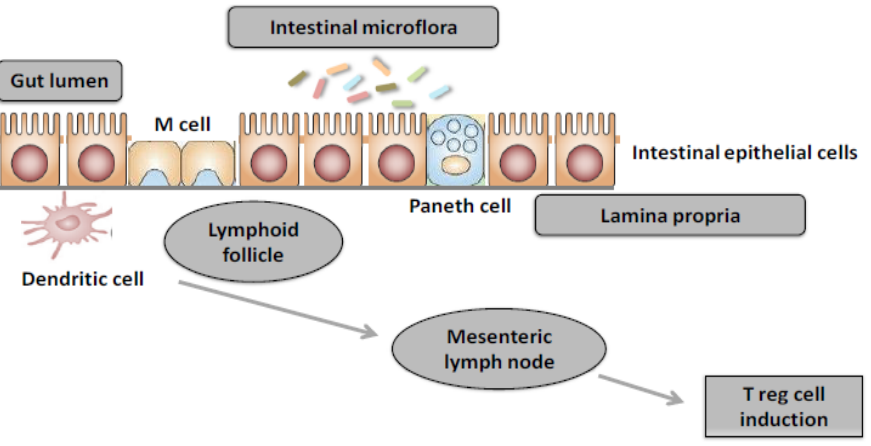
Figure 1. Intestinal microflora drives oral tolerance development. Under homeostatic condition, antigens from selected components of intestinal microflora are acquired in the lamina propria and presented in the mesenteric lymphonodes by CD 103 + dendritic cells. Through mechanisms mainly involving transforming growth factor (TGF) β and retinoic acid, dendritic cells induce the production of gut homing Treg cells. Treg cells actively suppress allergic sensitization to